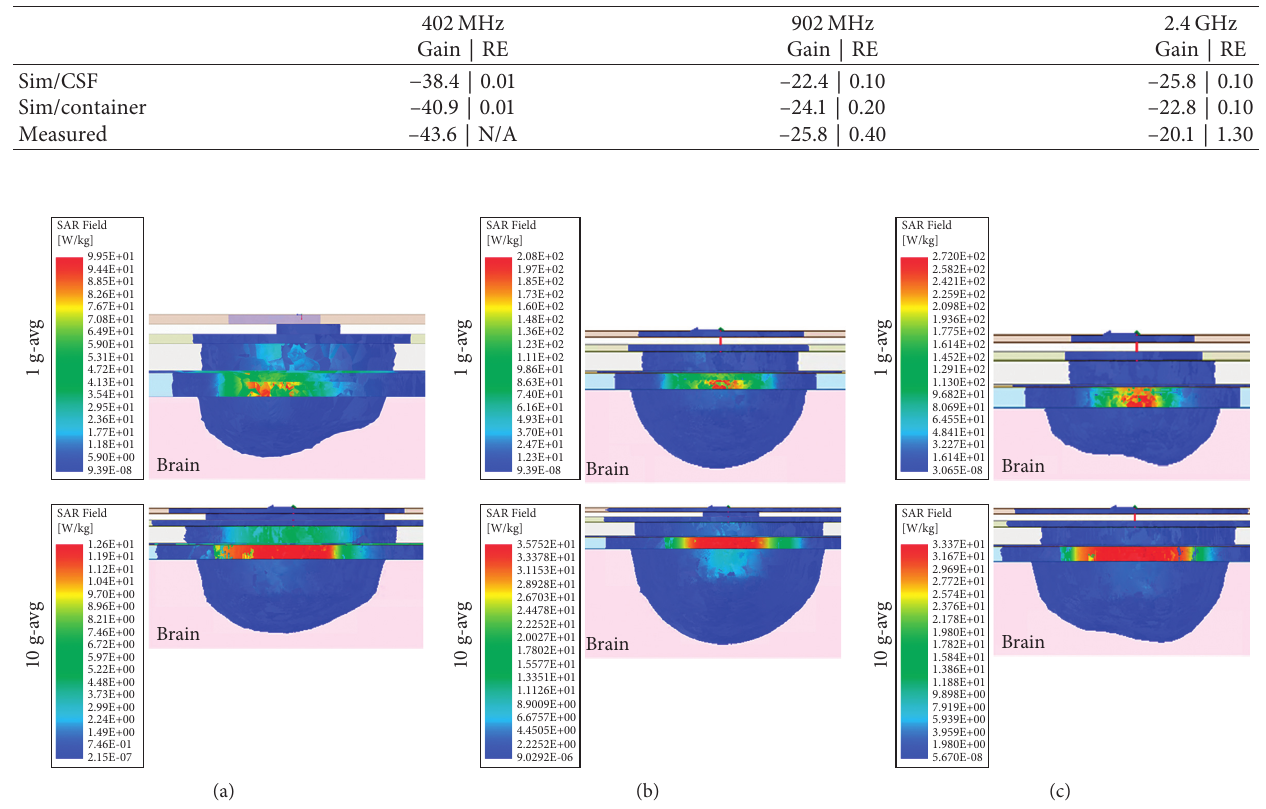
Figure 13: Simulated and measured realized gain of the implantable PIFA. Table 2: Antenna gain (dBi) and radiation efficiency (%).